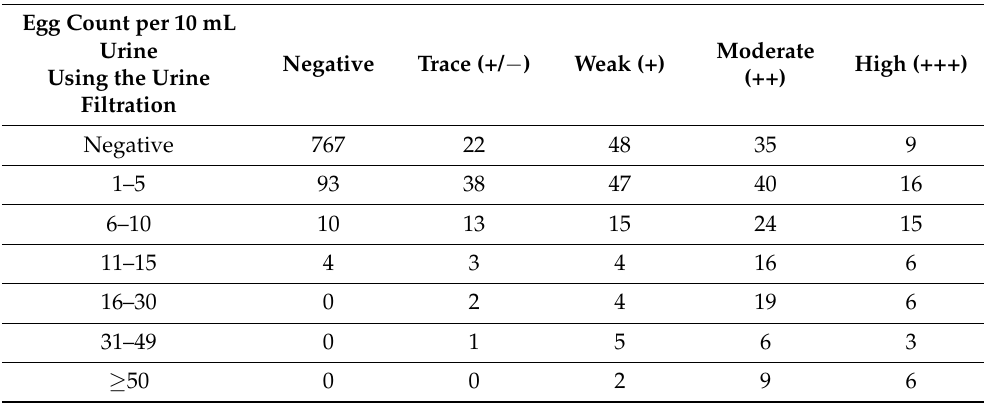
Table 3. Comparison of the urine filtration microscopy and the urine reagent strips in detecting the presence and estimating the intensity of Schistosoma haematobium infection in Ethiopia, October 2021 to April 2022. Level of Hematuria Using the Urine Reagent Strips Egg Count per 10 mL Urine Negative Trace (+/ − ) Weak Using the Urine Filtration